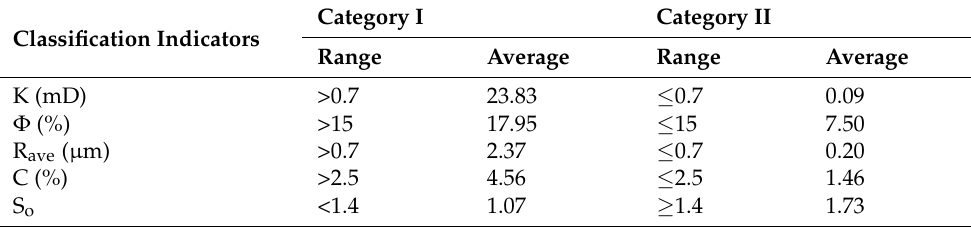
Table 6. Classification of the pore structure category of the deep-mine sandstone. Classification